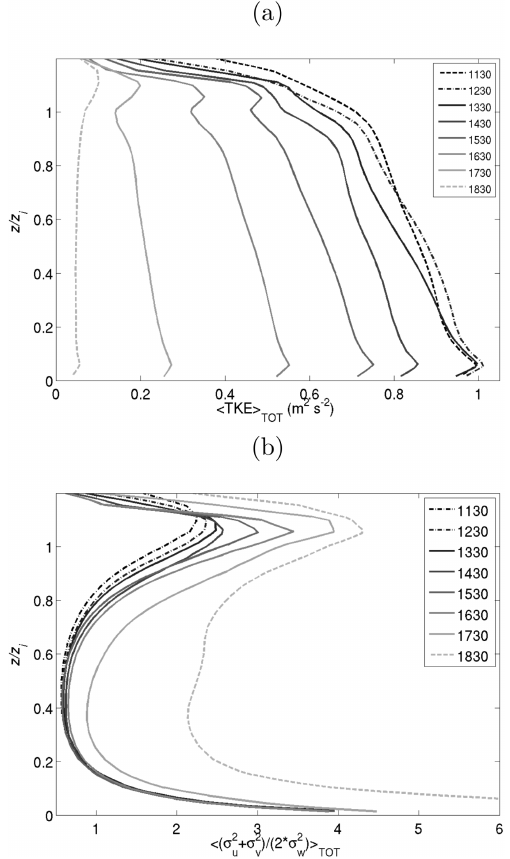
Figure 9. Vertical profiles of the total (resolved and subgrid (sub- script TOT)) (a) TKE and (b) anisotropy at several different hours during the AT in the